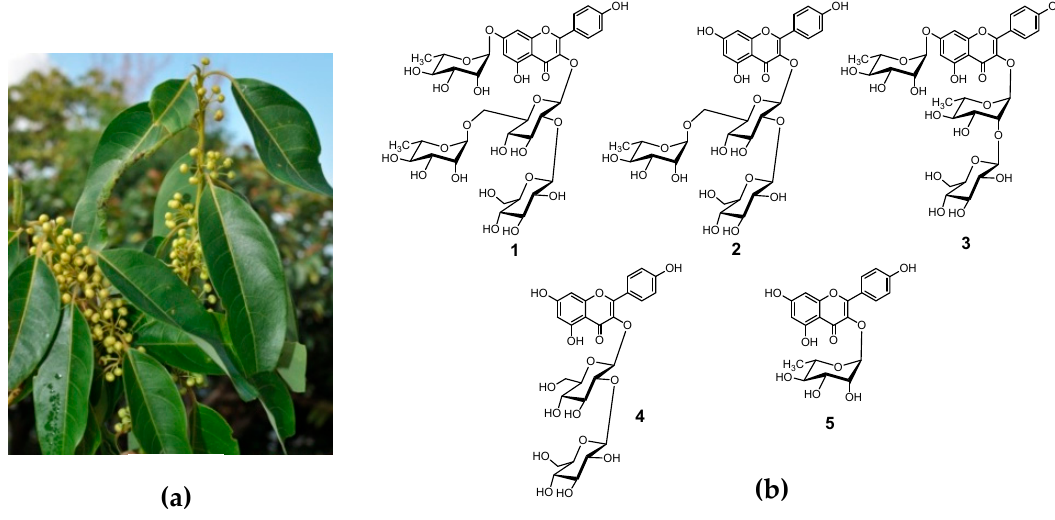
Figure 1. Photograph of Lindera neesiana ( a ) and the structures of compounds isolated from the leaves and twigs of Lindera neesiana ( b ).